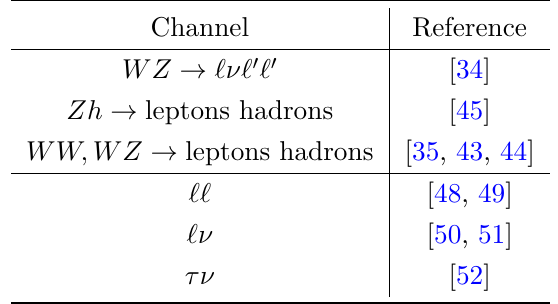
Table 1 . ATLAS and CMS di-boson and di-lepton searches considering DY and VBF production with a luminosity ∼ 140 fb − 1